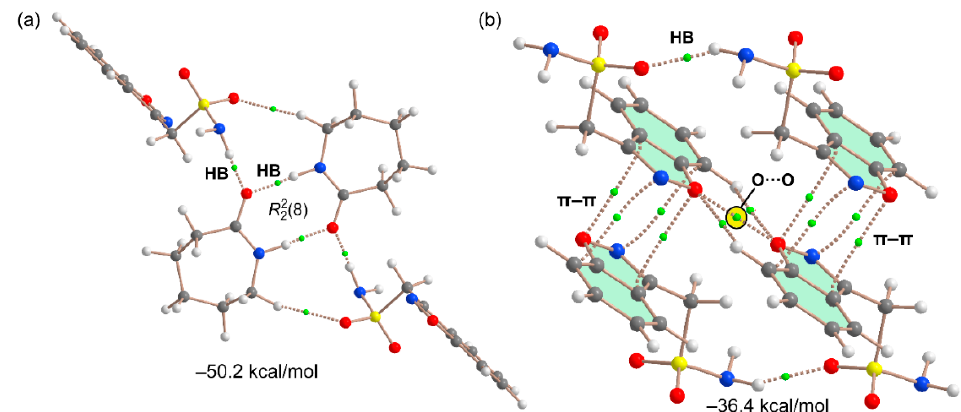
Figure 10. QTAIM analysis of intermolecular bond CPs (green spheres) and bond paths for the hetero ( a ) and homotetrameric ( b ) assemblies observed in the zonisamide/ ϵ -caprolactam cocrystal.